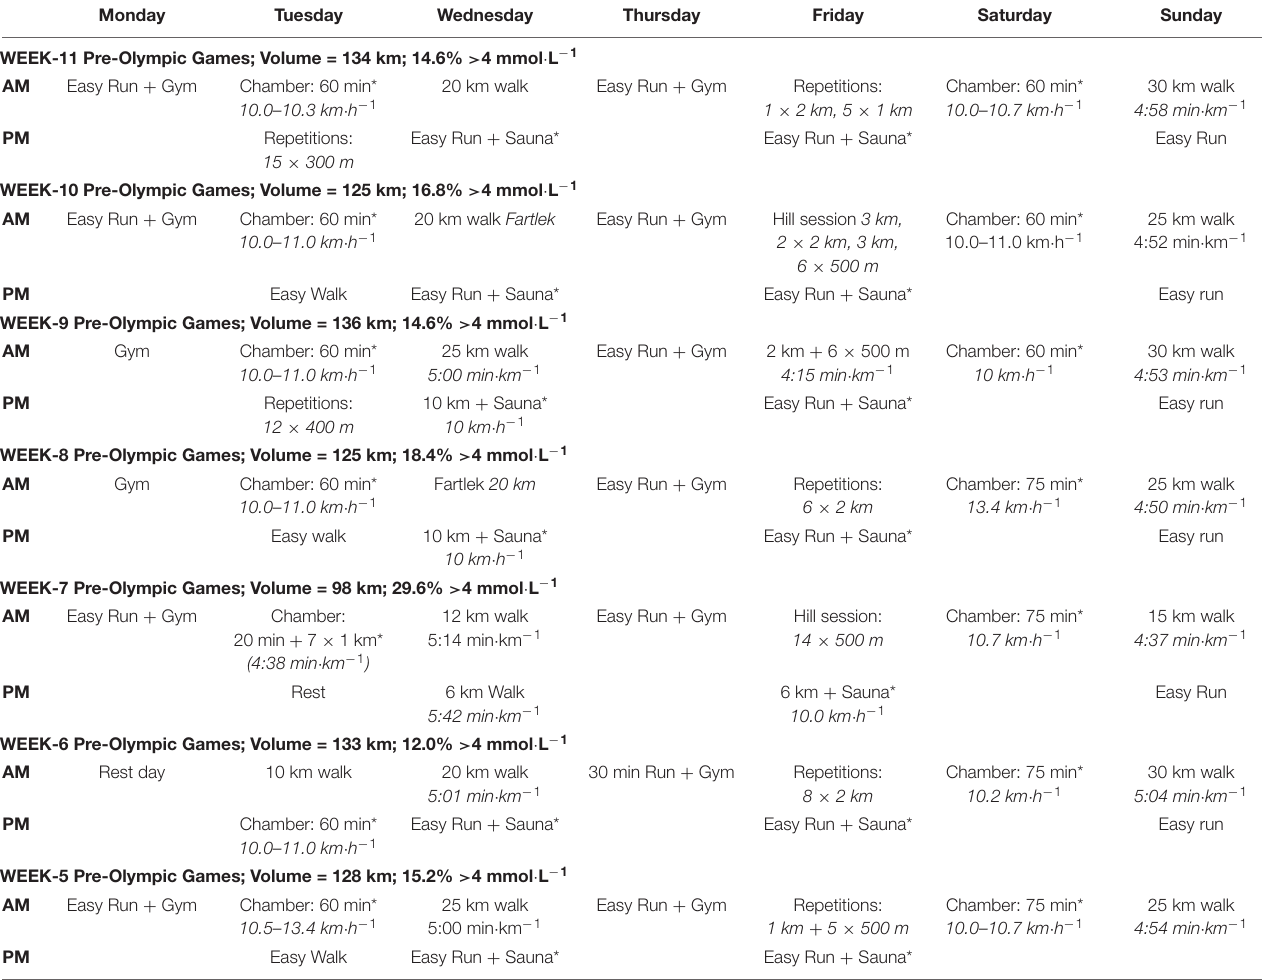
TABLE 1 | Example of training sessions performed for the 7 weeks prior to the team holding camp ( n = 1;